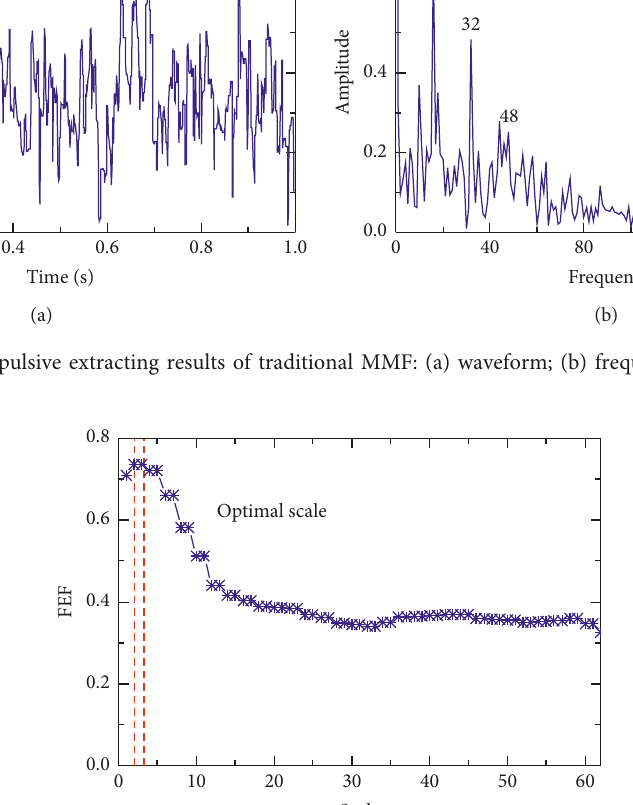
Figure 9: Relation curve between FEF and SE scale for simulation signal y ( t )